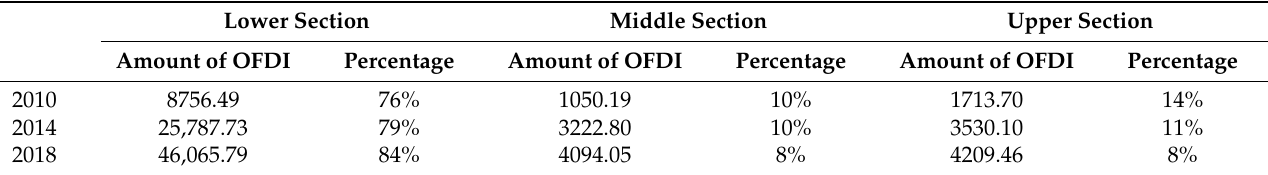
Table 3. Key indicators of the investment amount of OFDI in the Yangtze River Economic Belt (USD million). Lower Section Middle Section Lower Section Amount of OFDI